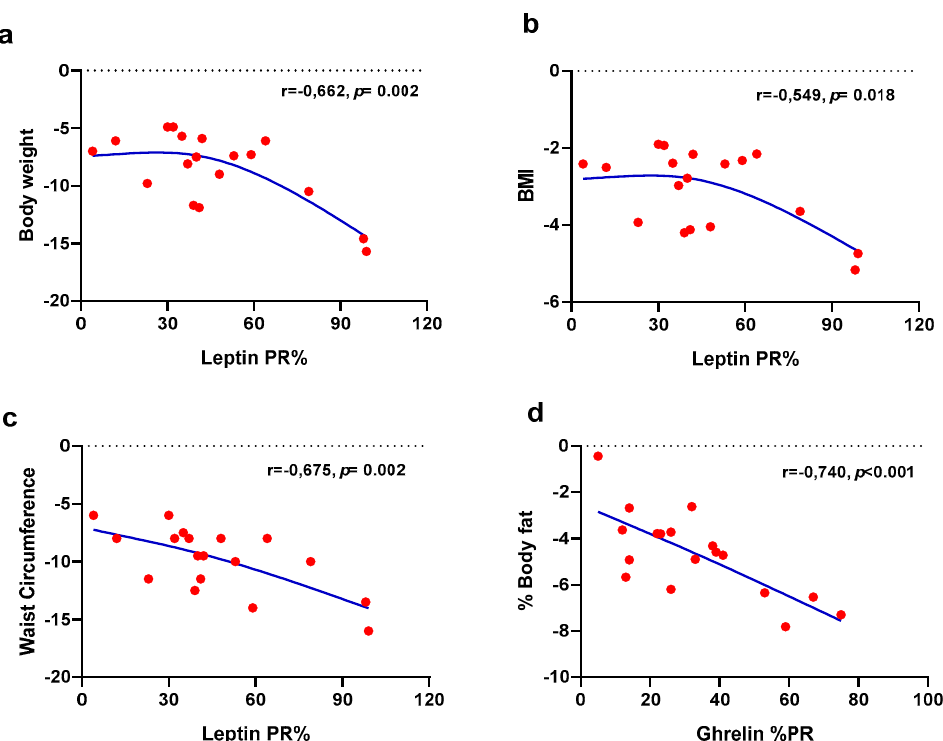
Figure 6. Association plots between the percentage of rhythmicity (PR%) of leptin and body weight ( a ), BMI ( b ), waist circumference ( c ) and the PR% of ghrelin and the body fat percentage ( d ) as indicators of the effectiveness of the weight loss dietary intervention. Pearson’s correlation analysis was used to obtain the correlation coefficients (r) and their associated significance level ( p ). Lines were smoothed using a smoothing spline with degree of freedom ( df ) = 3. The detailed description of the statistically significant correlation coefficients is presented in Table S3.